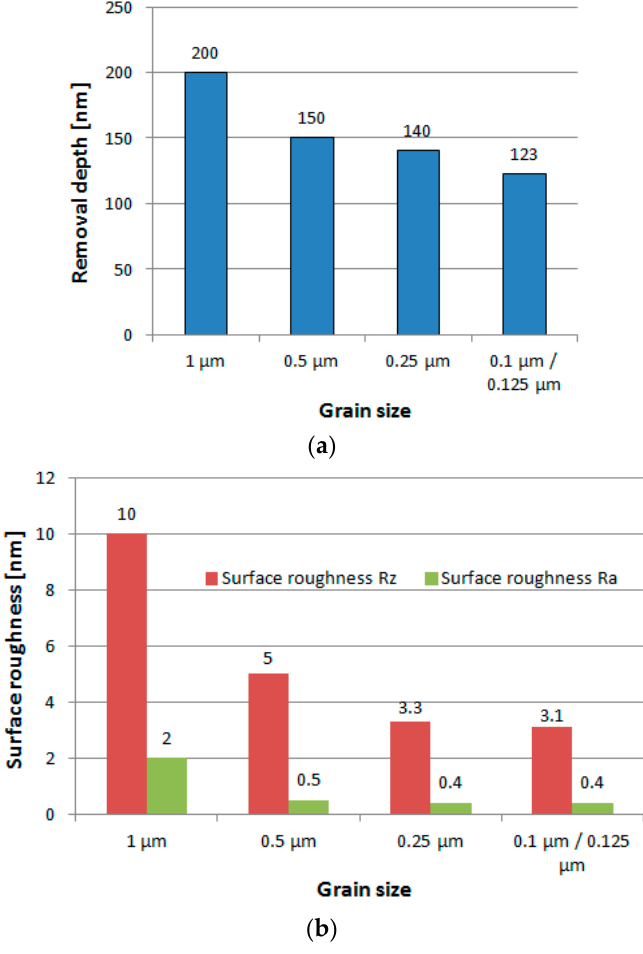
Figure 8. Effects of abrasive grain size on ( a ) material removal and ( b ) surface roughness.